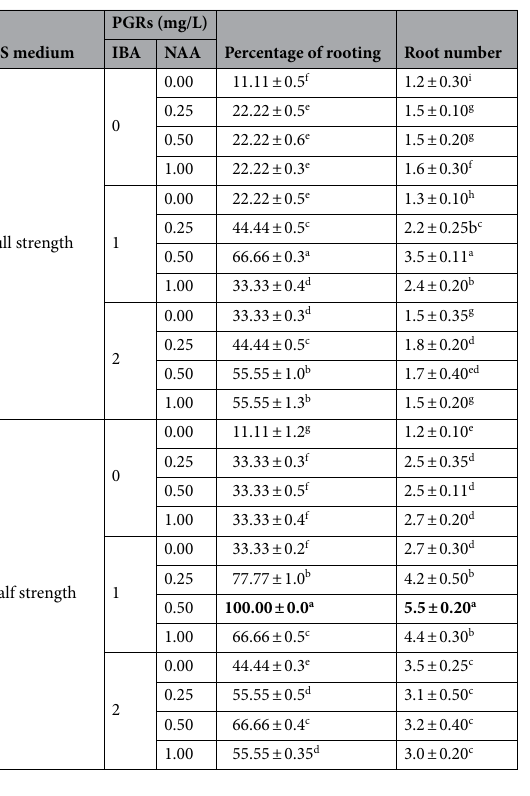
Table 4. Effects of auxins (IBA, NAA and IBA * NAA) on the rooting of R. coriaria. Each value represents the mean ± SE of three replicates. Different lowercase letters in the same column indicated the significant difference at P ≤ 0.05 (Duncan’s multiple range test). The bold values indicates the best treatment for